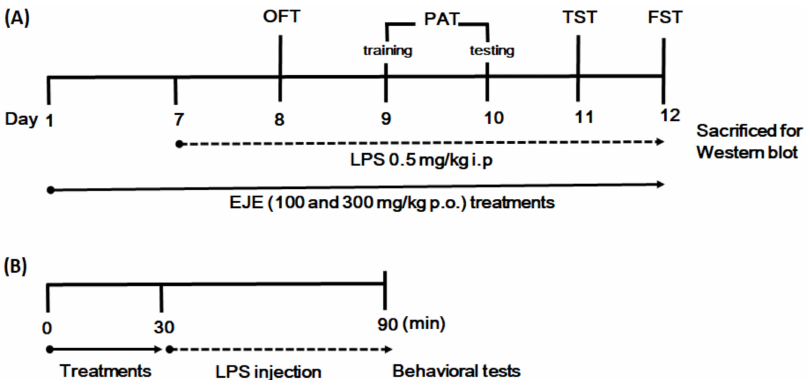
Figure 2. Experimental design to evaluate the e ff ect of EJE on LPS-induced depressive mice. ( A ) After seven days of sample treatments, the mice underwent the depression-related behavioral tests. ( B ) Mice were pretreated with the samples 30 min prior to LPS injection, then, OFT, PAT, TST, and FST tests were determined 60 min after LPS injection. After the last FST session, mice were sacrificed for western blot analysis. EJE, E. japonicum extract; LPS, lipopolysaccharide; OFT, open field test; PAT, passive avoidance test; TST, tail suspension test; FST, forced swim test; i.p., intraperitoneal; p.o., per